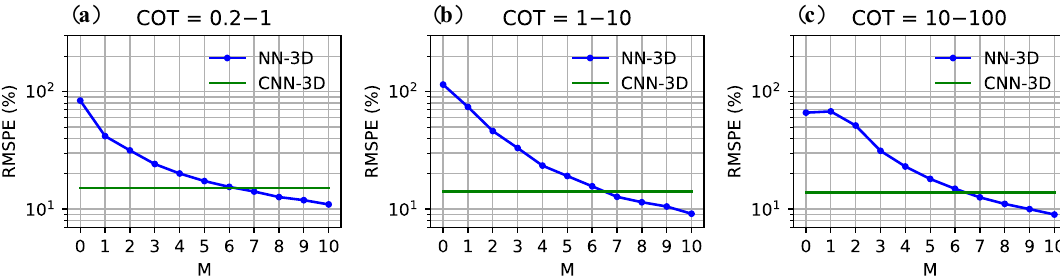
Figure 7. Root-mean-square percentage errors (RMSPEs) as functions of the number of input-image pixels of the multi-pixel NN (NN-M) estimation model for ( a ) COT = 0.2–1, ( b ) COT = 1–10, and ( c ) COT = 10–100. For the number M in the horizontal axis, the number of input-image pixels is (2 M + 1) 2 , including the target pixel and surrounding pixels. For comparison, the RMSPE for the CNN-3D model is plotted with identical values, independent of the number of surrounding pixels.